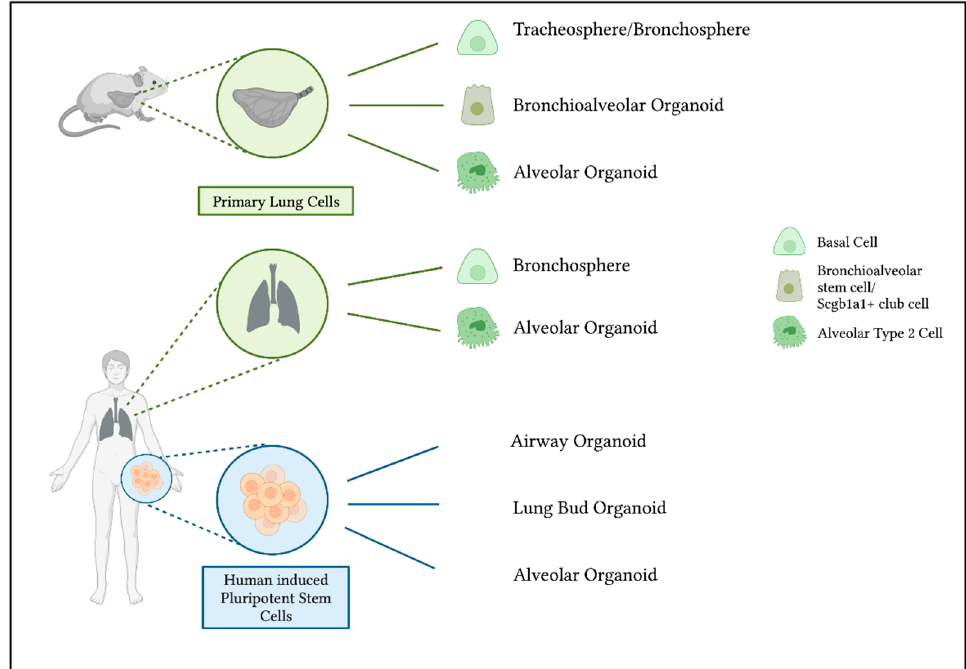
Figure 1. Generation of murine and human lung organoids and their cells of origin. Organoids can be derived from primary murine and human lung cells. Tracheospheres and bronchospheres originate from airway basal cells [44,45]. To generate bronchioalveolar organoids from murine lungs, bronchioalveolar stem cells or Scgb1a1+ club cells can act as progenitors to bronchiolar as well as alveolar cells [46,47]. Primary isolated alveolar type 2 cells are able to differentiate into alveolar organoids [48,49]. Another possibility to generate lung organoids is the use of human induced pluripotent stem cells. The use of different growth factors and conditions results in either airway [50] or alveolar organoids [51,52]. Organoids that include bronchial as well as alveolar cells can be derived as so-called lung bud organoids [53].